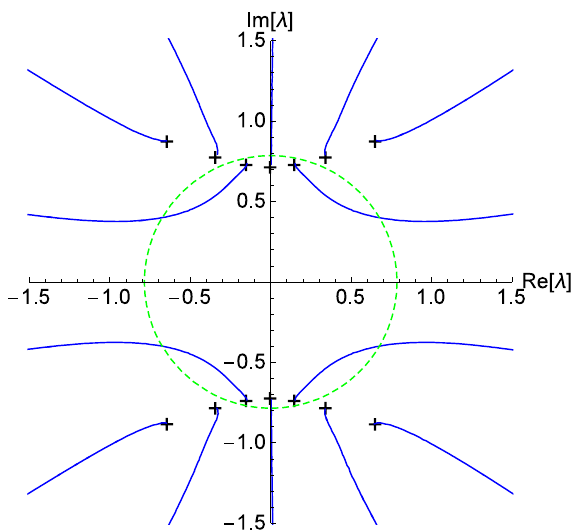
Figure 18 . Analytic property of the FPR with ( m; n; (cid:11) ) = (15 ; 2 ; 1 = 32) as a complex function of (cid:21) . The symbol \+" denotes zeros of the rational function ( F ( (cid:11) ) m;n ) 1 =(cid:11) , which give ends of branch cuts of F ( (cid:11) ) m;n The green dashed line denotes j (cid:21) j = (cid:25)= 4, which is expected radius of convergence in the weak coupling